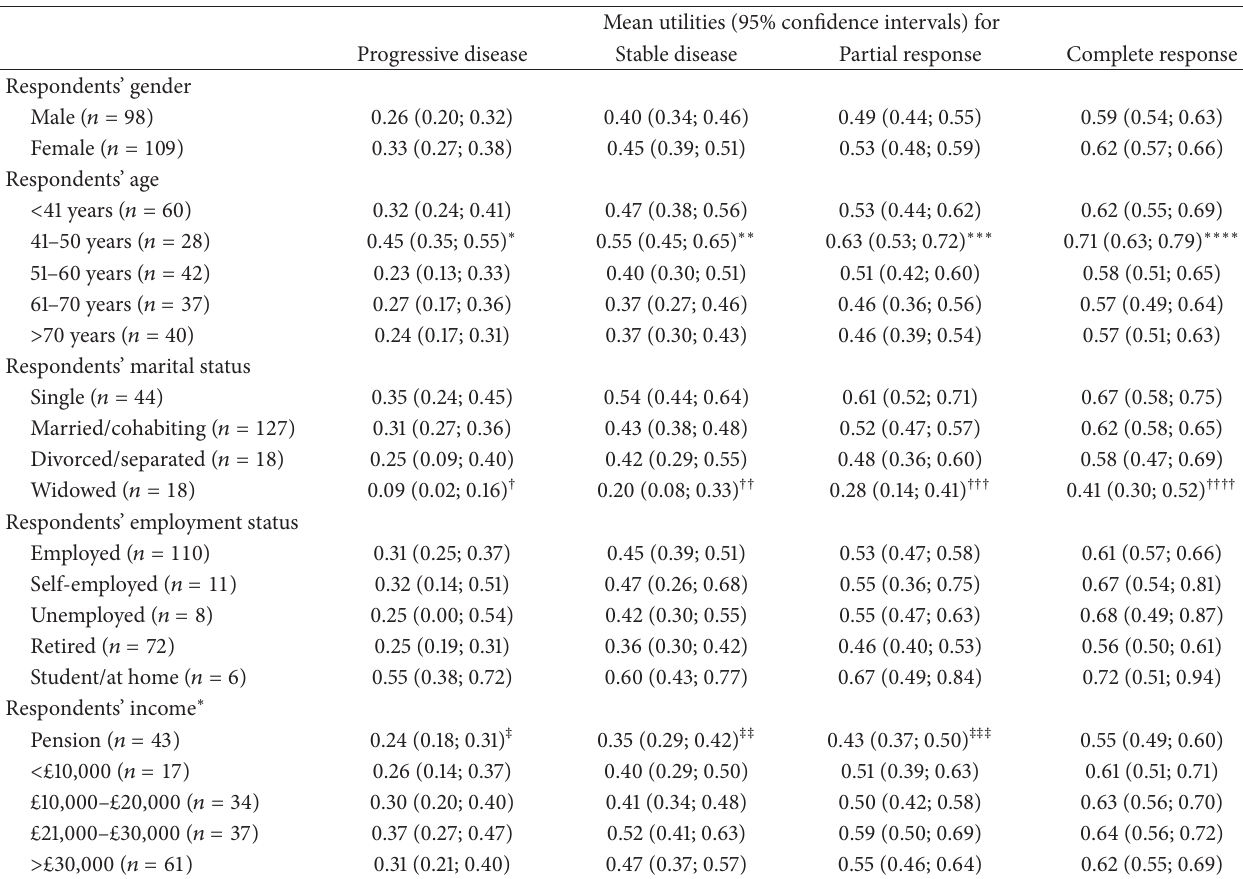
Table 4: Mean utilities (95% confidence intervals) for ASTS health states, stratified by socio-demographic parameters, using TTO. ( ∗ 15 respondents refused to provide details about their